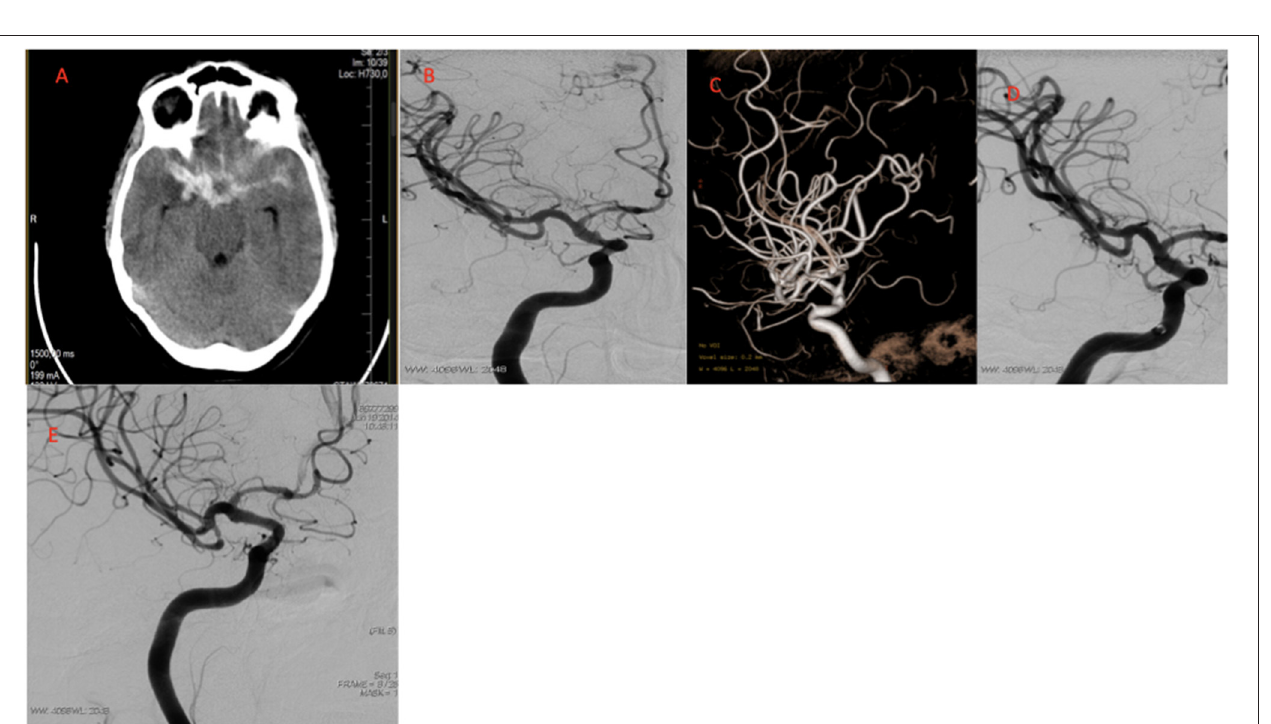
diagnostic criteria of BBAs have not been established